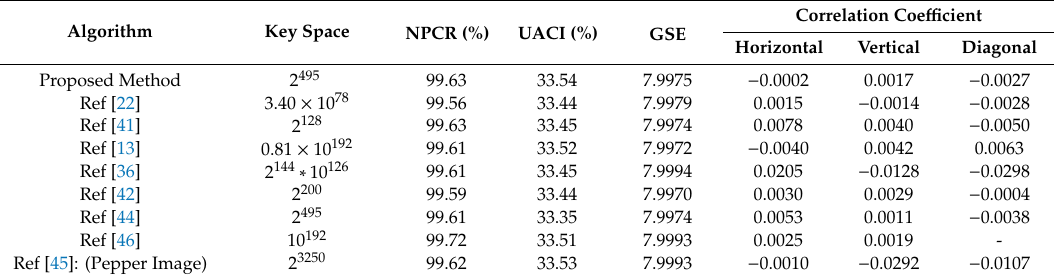
Table 11. Comparison of keyspace, NPCR, UACI, GSE, and correlation coe ffi cient values between the proposed work and the existing